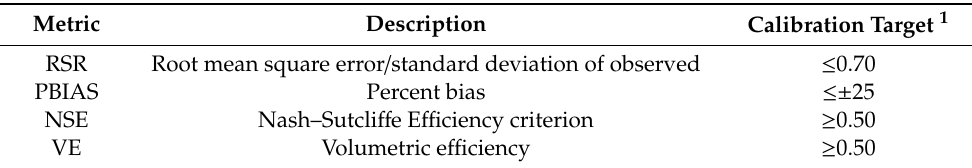
Table 3. Error metrics used in the objective